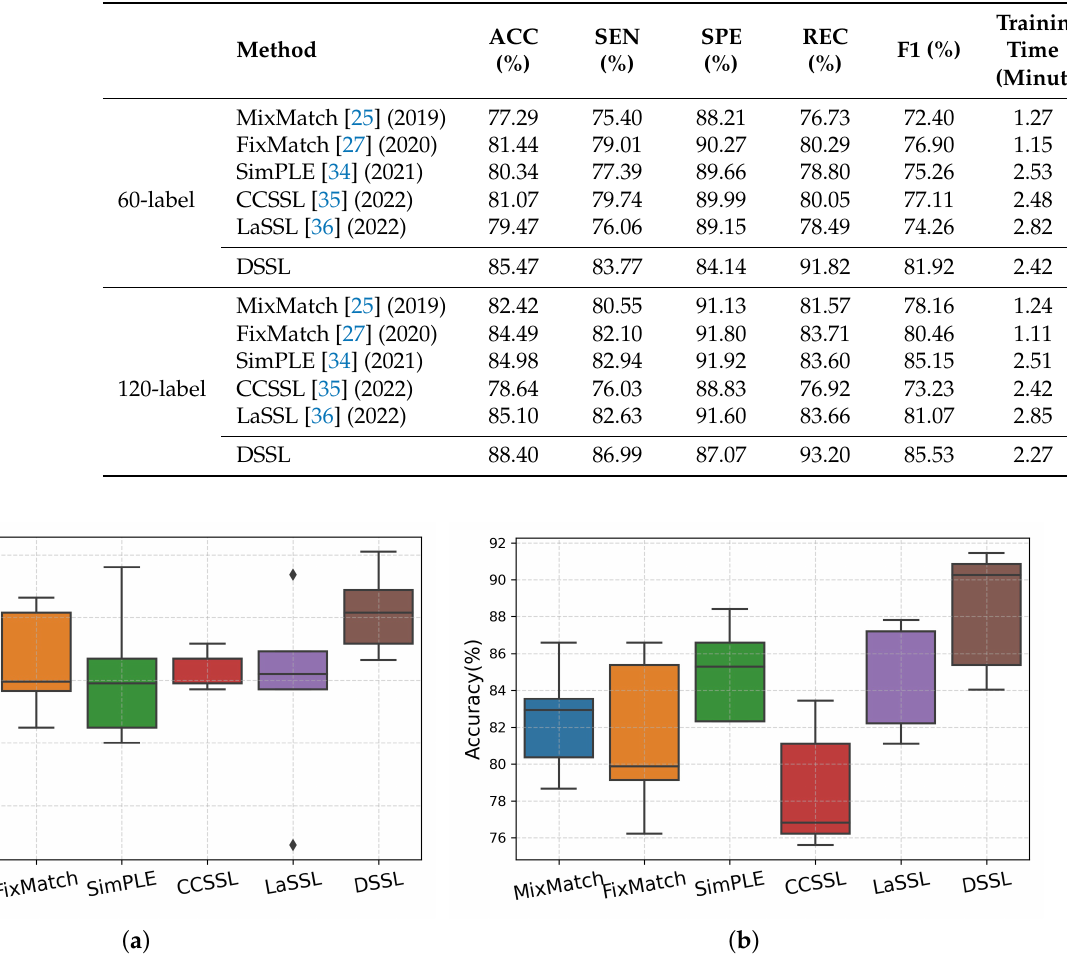
Table 5. The semi-supervised evaluation results of each model for the ADNI database data in the 60-label and 120-label cases.